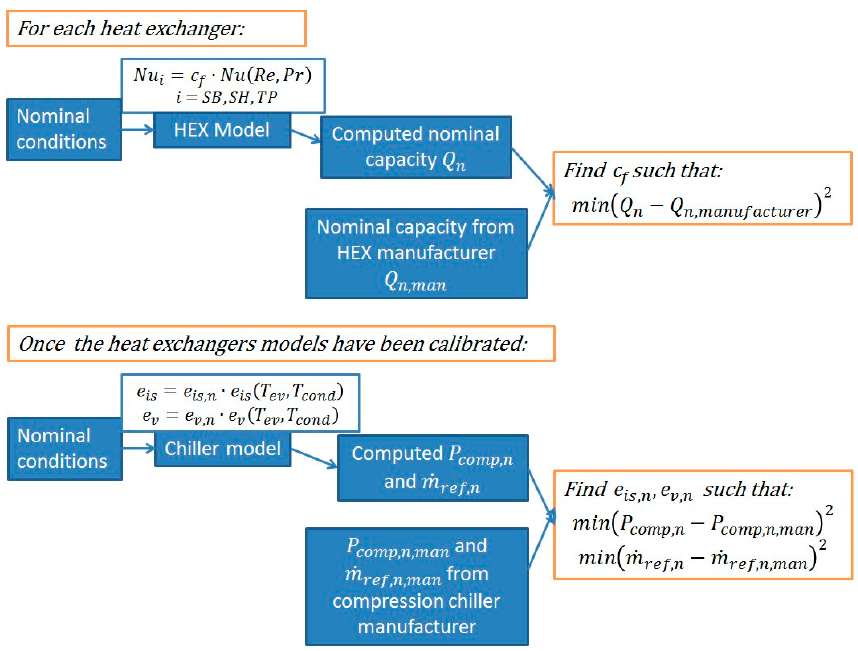
Figure 8. Representation of the compression chiller model calibration procedure.